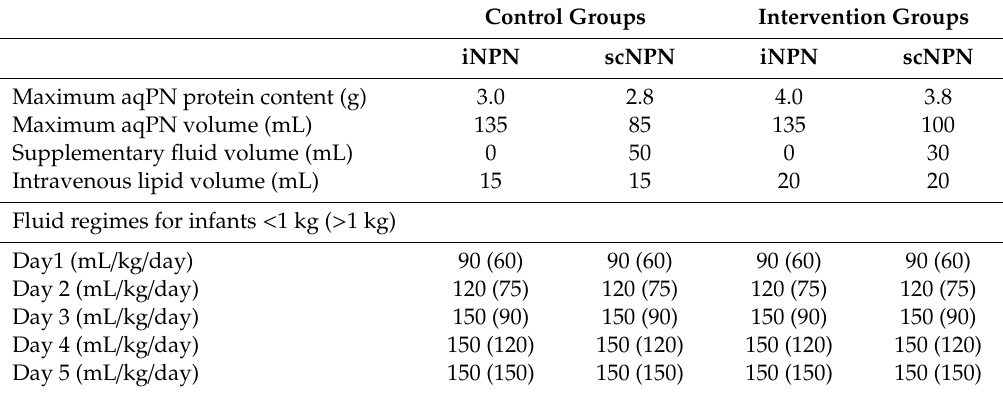
Table 1. Description of parenteral fluid components in each randomised controlled trial (RCT) group demonstrating the concentration of parenteral protein with standardised concentrated neonatal parenteral nutrition (scNPN) [8] compared with individualized NPN (iNPN) [5]. The total daily fluid intake policy was identical in both RCT with clinicians restricting or increasing fluids based on individual patient